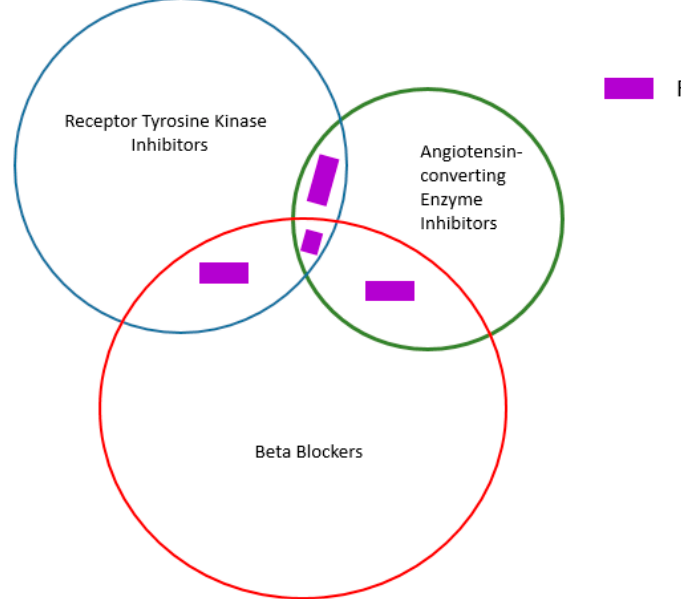
Figure 3. Algorithm for drug repurposing. In this example, a Venn diagram comprising Erdos interactomes for receptor tyrosine kinase inhibitors, angiotensin converting enzyme inhibitors and beta blockers is shown. Intersection sets represent drugs that can be repurposed. For example, the intersection set between the red and green interactomes represent drugs or drug candidates that can potentially find use as angiotensin converting enzyme inhibitors or beta blockers.